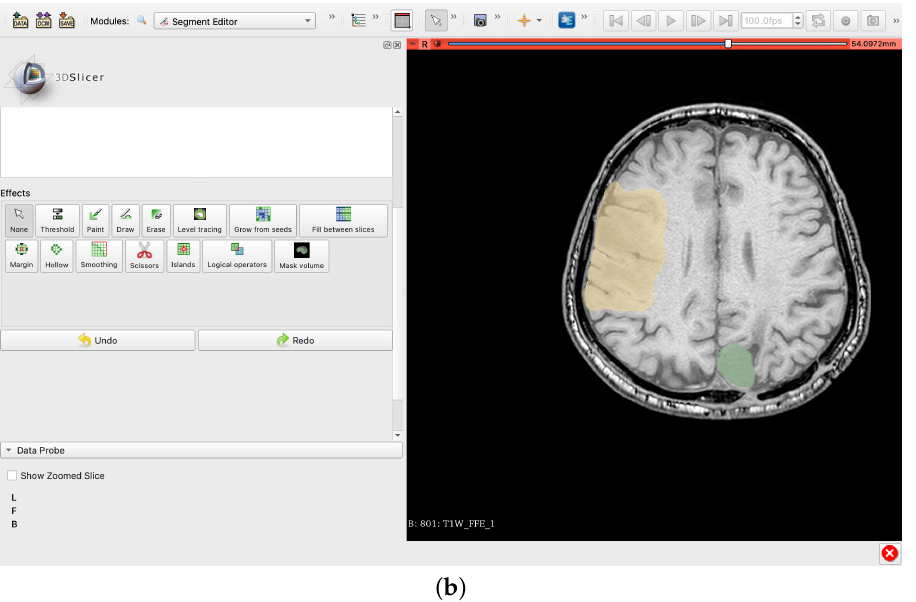
Figure 4. Experimental assessment, first patient. Segmentation with slicer 3D ( a ) coronal, sagittal, transversal, and 3D visualization, ( b ) only transversal visualization, yellow area malignant tissue, light green area benignant tissue.